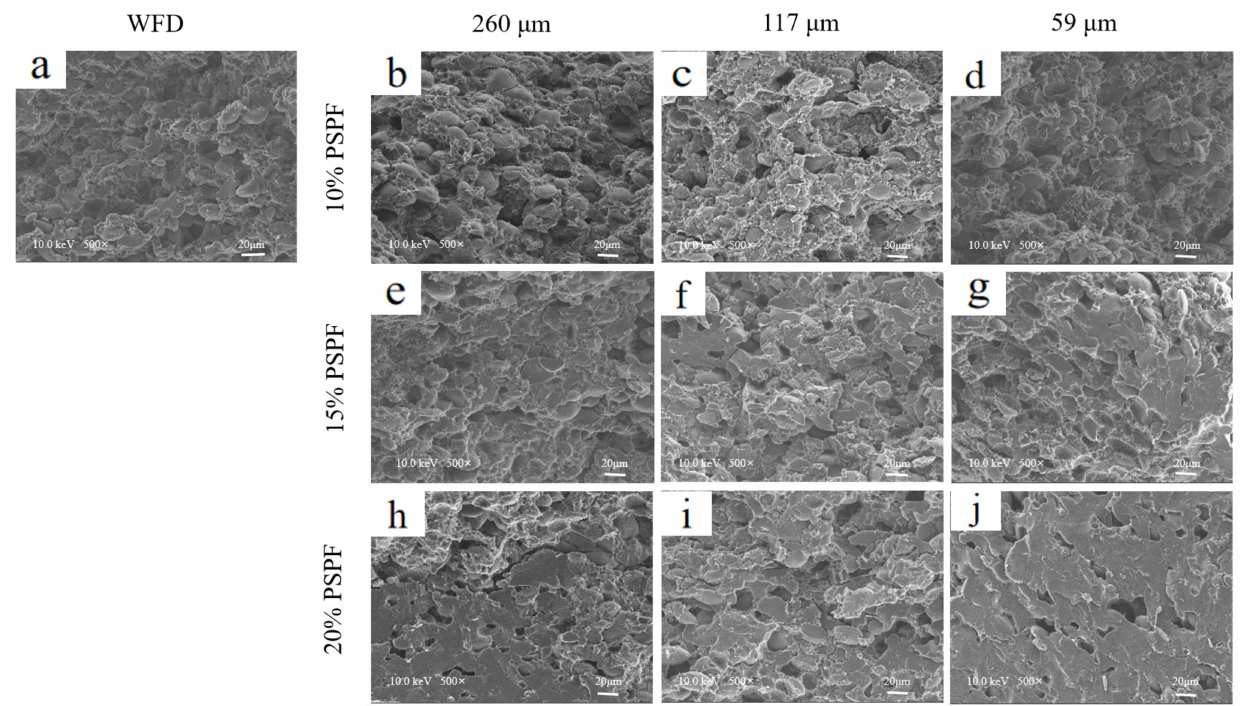
Figure 2. SEM images of the cross-sections of WFD ( a ) and PSPD ( b – j ) with different addition levels (10%, 15%, and 20%) and particle size (260 µ m, 117 µ m, and 59 µ m) of